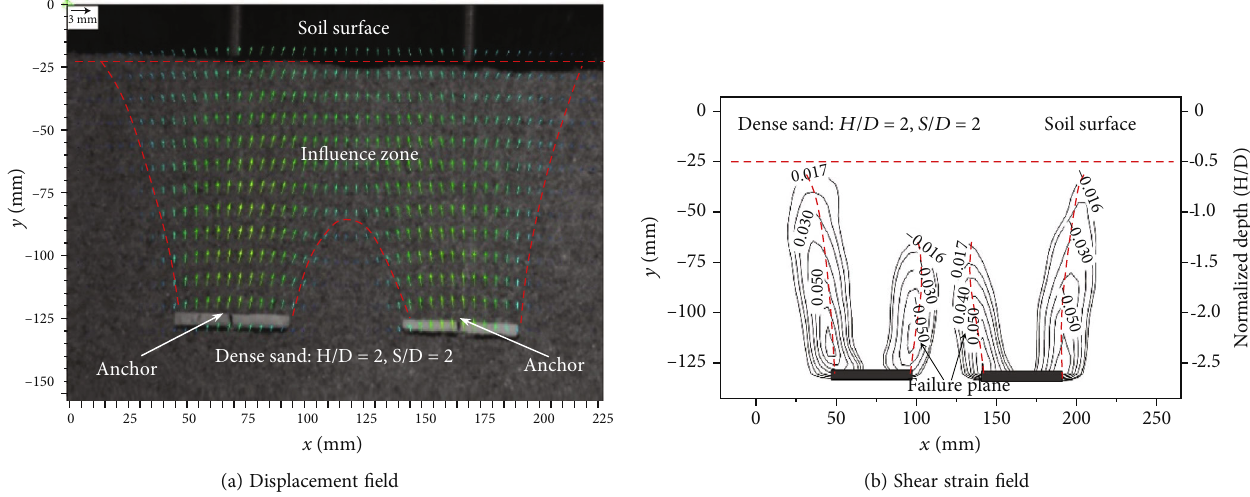
Figure 6: Soil displacement and shear strain fi elds for a shallow group anchor in dense